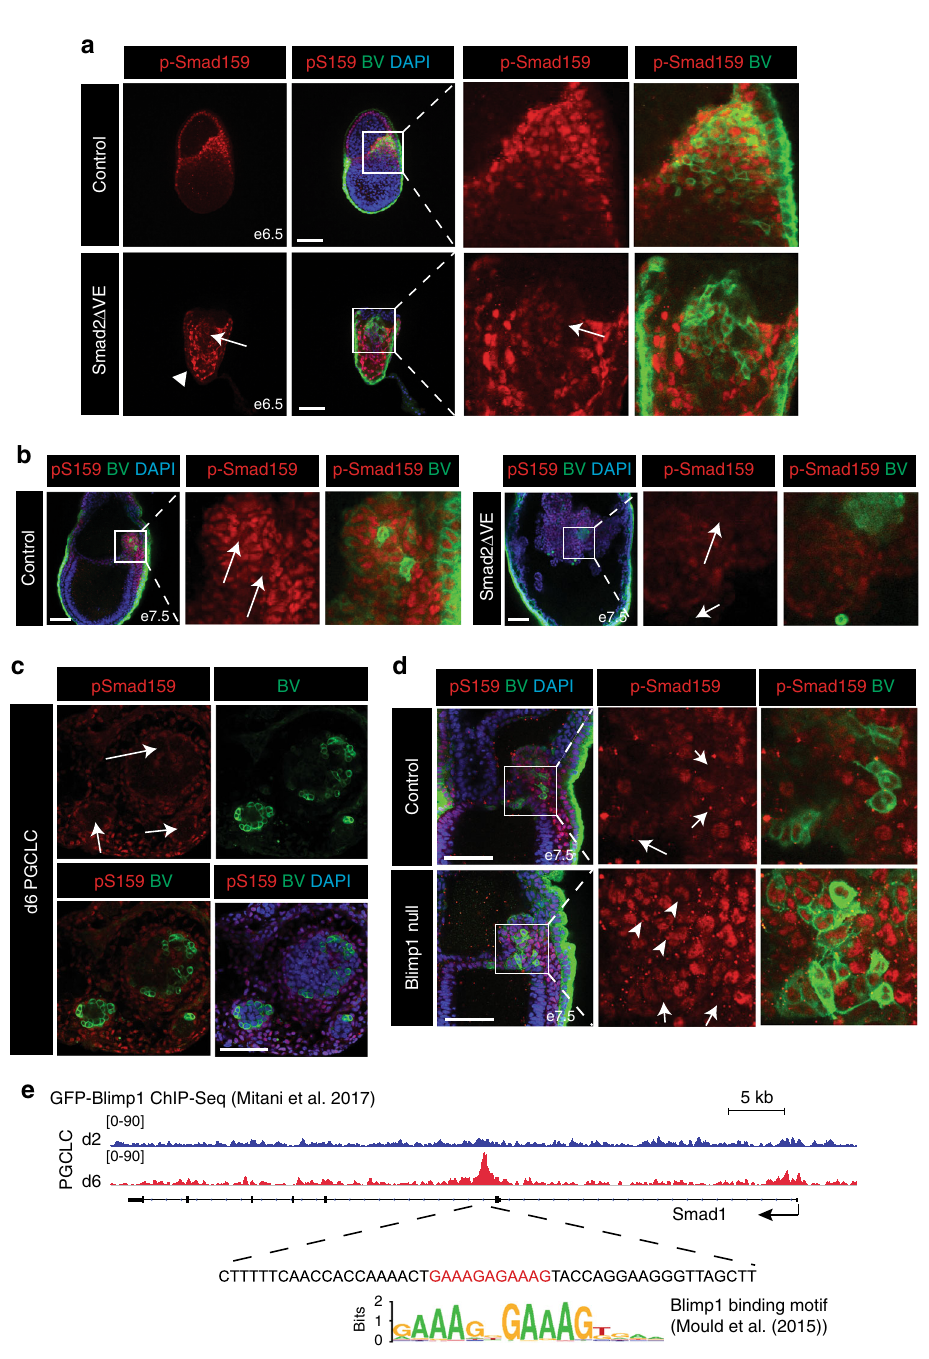
Fig. 5 PGCs down-regulate p-Smad159 to become refractory to the high-Bmp signalling environment. a p-Smad159 staining of BV + cell populations. Arrowhead con fi rms e6.5 Smad2 Δ VE embryos lack p-Smad159 in the VE, while arrows indicates weak activity in BV-expressing epiblast cells. b p-Smad159 staining in control and Smad2 Δ VE BV + embryos at e7.5. Arrows indicate loss of p-Smad159 staining in BV high-expressing cells. c p-Smad159 staining in BV + wild-type d6 PGCLC aggregates. Arrows indicate BV + cell populations lacking p-Smad159 reactivity. d p-Smad159 staining in control and Blimp1 − / − BV + embryos at e7.5. Arrows indicate reduction of p-Smad159 reactivity in BV high-expressing cells in expanded panels. Arrowheads indicate retained p- Smad159 activity in BV + cells in the Blimp1 − / − mutant embryo. All IF images are counter stained with DAPI. Scale bars = 100 μ m. e Genome browser track view of GFP-ChIP wiggle plots from GFP-Blimp1 expressing PGCLC cultures at day (d)2 (blue) and d6 (red) showing enrichment of GFP-Blimp1 density at a Smad1 intronic region. The sequence below the GFP-Blimp1 ChIP site contains a Blimp1 binding motif indicated in red. The consensus Blimp1 binding motif previously identi fi ed by genome-wide ChIP-seq data sets is also indicated